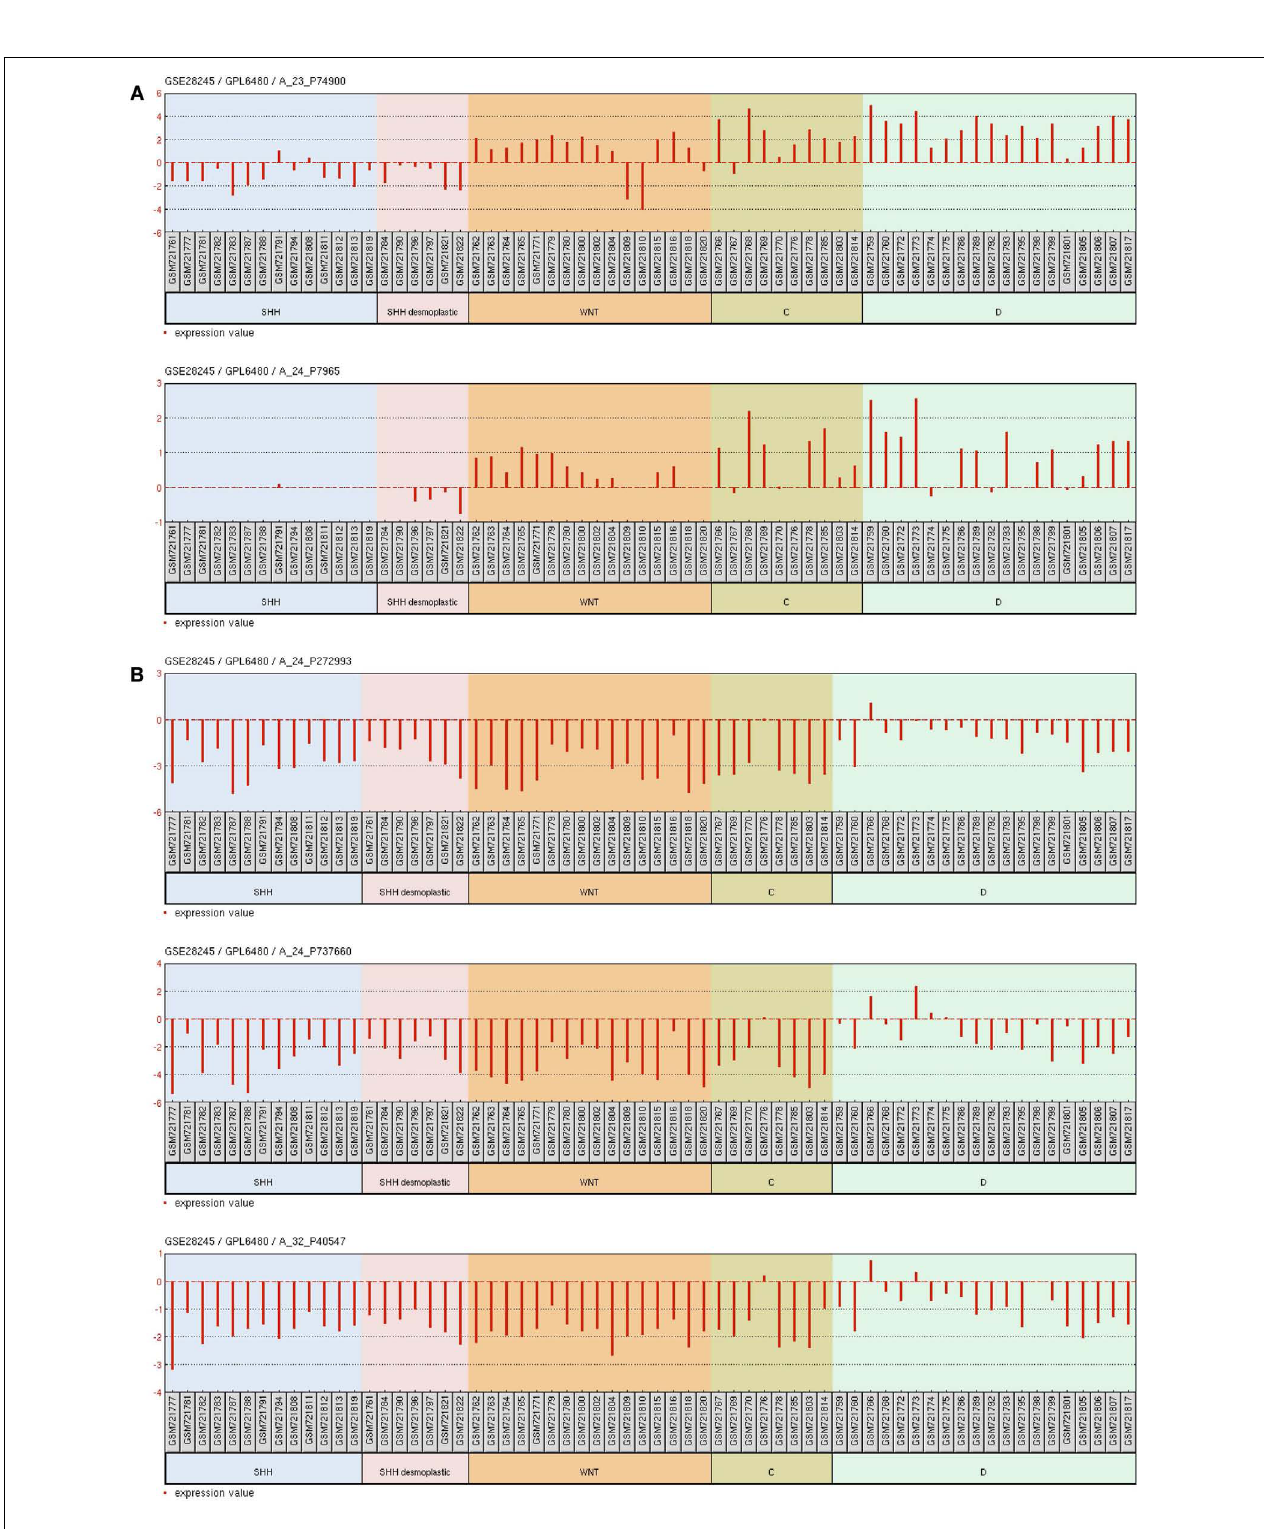
Omnibus. (A) probe sets for ESRRG . (B) Probe sets for MEG3. Samples were grouped according to the molecular MB subgroups intoWNT, SHH, C, and D. SHH desmoplastic was separated from SHH